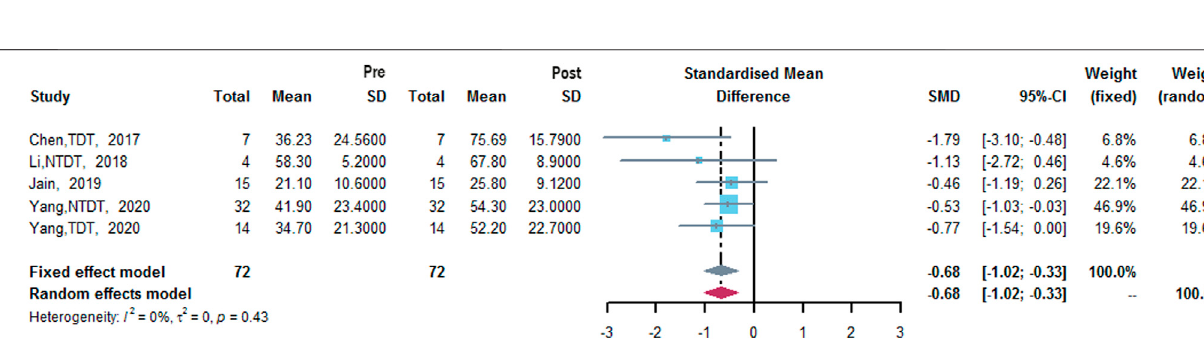
FIGURE 5 | A forest plot illustrating HbF level (%) after the treatment of thalidomide.